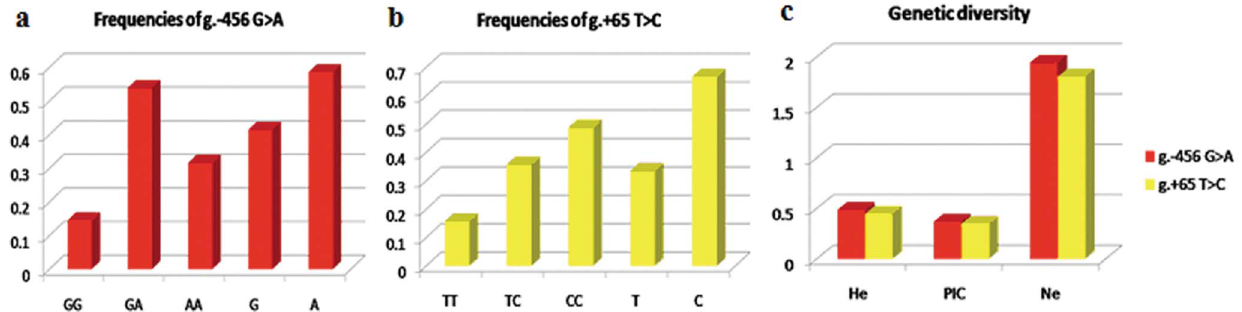
Figure 3. Distribution of genotypic and allelic frequencies of the PLCz loci (a) g. 2 456 G . A and (b) g. + 65 T . C in Chinese Holstein bulls. (c) Genetic diversity of PLCz in the sample